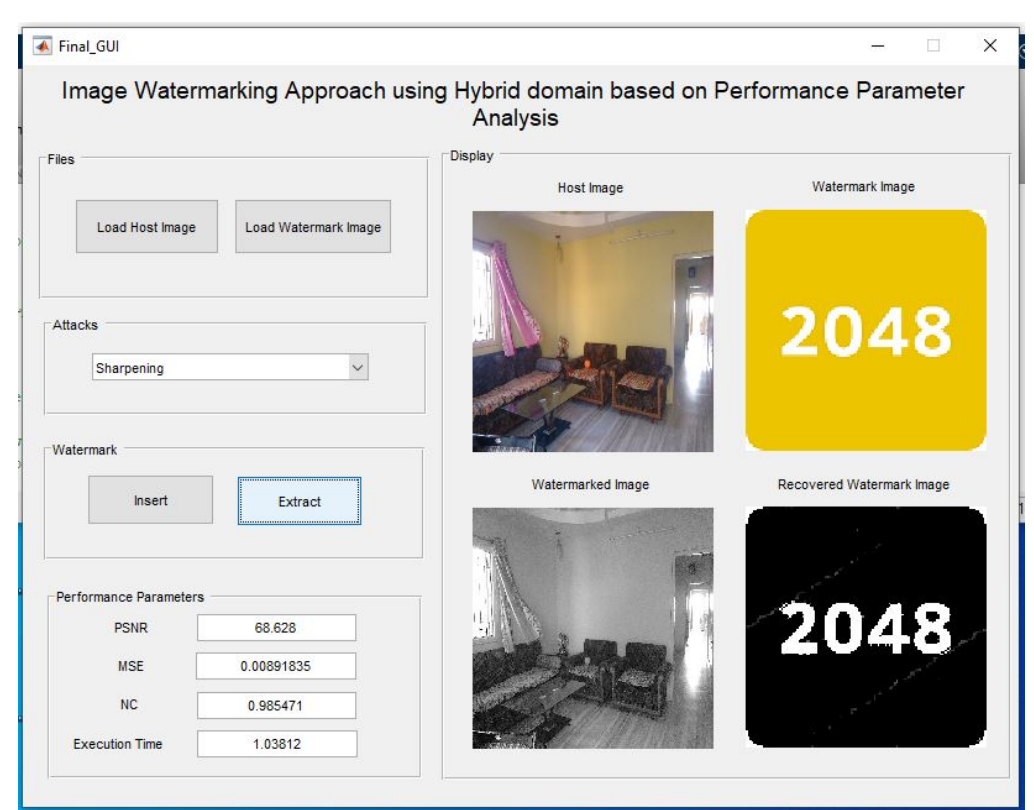
Figure 17. Sharpened watermarked image and extraction after sharpening of the watermarked image. The following Table 5 compares the extracted watermark with the original water- mark, for checking the similarity and for measuring normalized correlation. Table 5. Comparison of extracted watermark with original watermark of size 128 × 128.